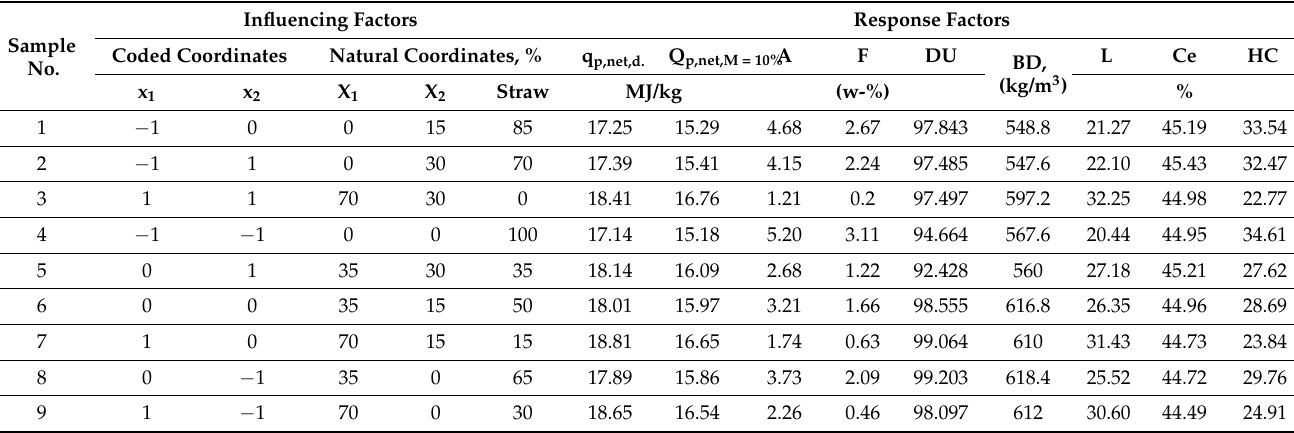
Table 2. Experimental plan used to optimize the composition of biomass mixtures of seabuckthorn (Seabuckthorn), blackberry (Blackberry), and straw.